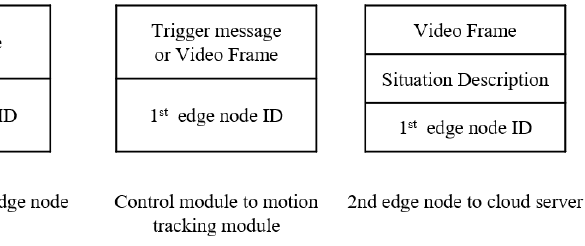
Figure 4. Message